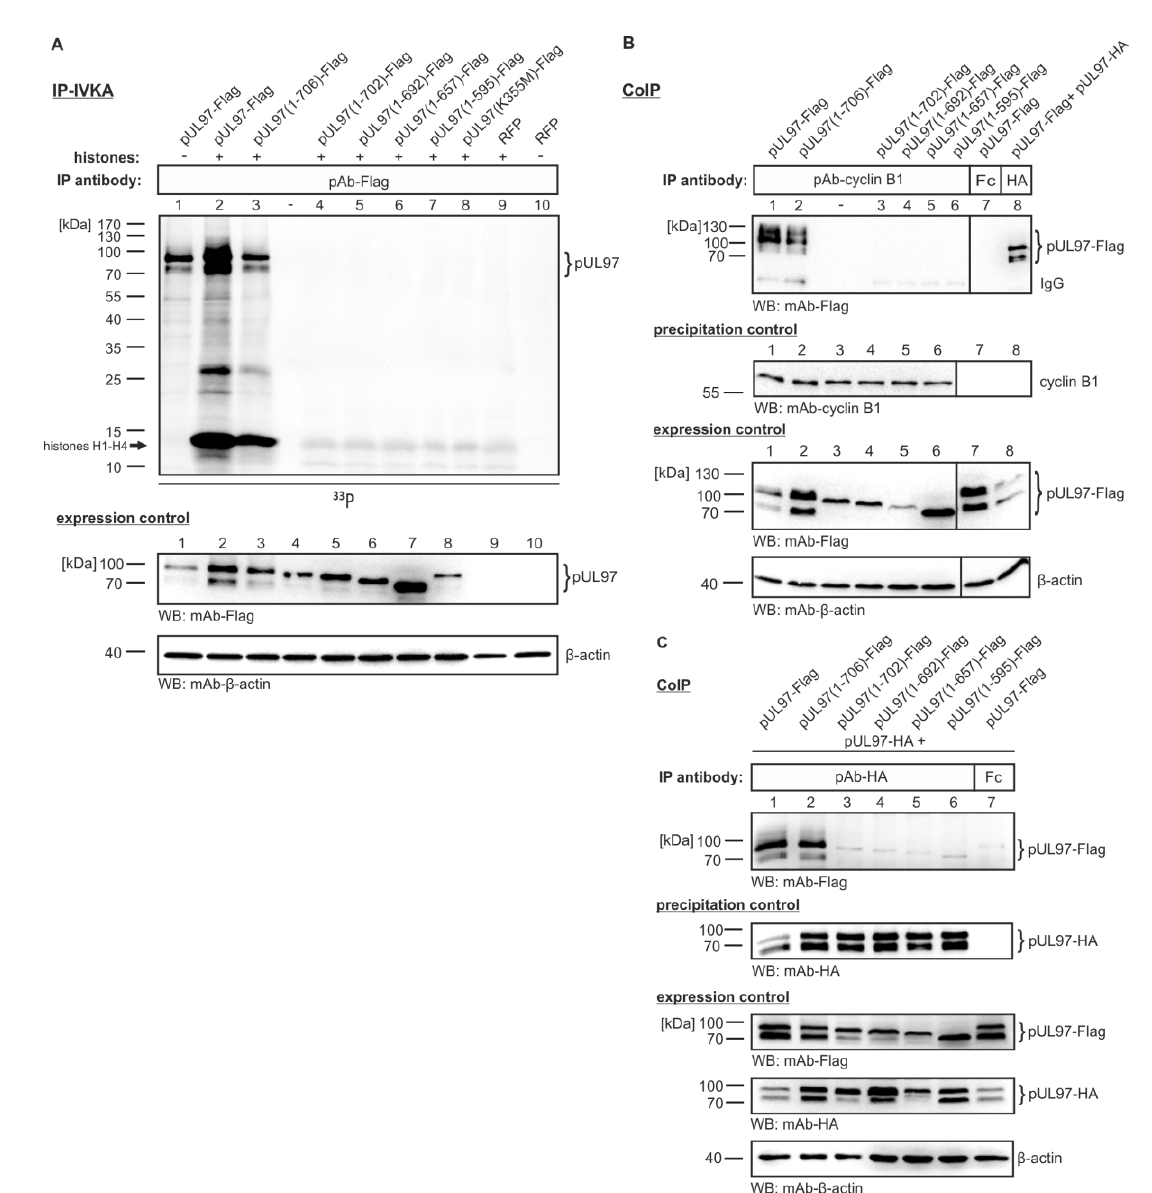
Figure 4. Importance of the C-terminus of pUL97 for kinase activity, cyclin B1 binding and pUL97-pUL97 interaction. Full-length pUL97 and C-terminally truncated versions lacking 1, 5, 15, 50 or 112 amino acids were transiently transfected into 293T cells (concentrations of plasmid DNA were adjusted between 10 µ g and 20 µ g to achieve homogeneous expression levels). Three days post-transfection, cells were lysed and endogenous cyclin B1 ( B ) or cotransfected pUL97-HA ( C ) was immunoprecipitated. Coimmunoprecipitated proteins (pAb-cyclin B1, positive control mAb-HA, negative controls rabbit Fc fragment and pre-immune serum not shown) were analyzed via WB analysis ( B , C ). For measuring in vitro kinase activity of C-terminally truncated versions of pUL97, an IVKA was performed with the immunoprecipitates ( A ). In reactions 2–9, a standard substrate of pUL97, i.e. , purified histones H1-H4 (comigrating in one band as resulting from the chosen SDS-PAGE conditions), was added exogenously together with [ γ - 33 P]-ATP. Phosphorylated proteins were separated by SDS-PAGE/WB and analyzed on a phosphoimager plate.